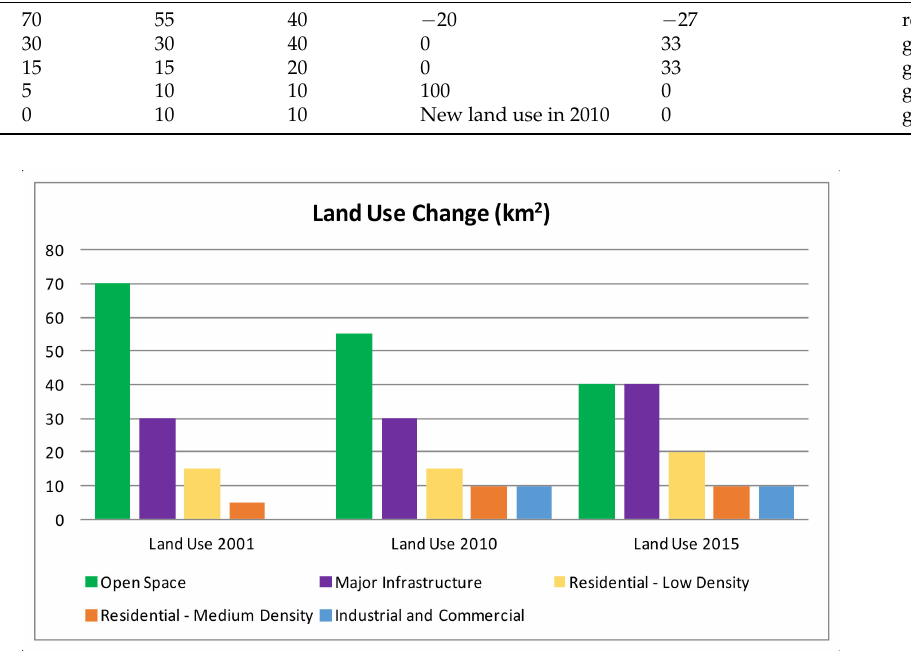
Figure 8. Land use change example: northeast Calgary. Left, 2001; Middle, 2010; Right 2015. Table 4. Summary statistics of land use change (area in km 2 ) between the years 2001, 2005, and 2015. Land Use